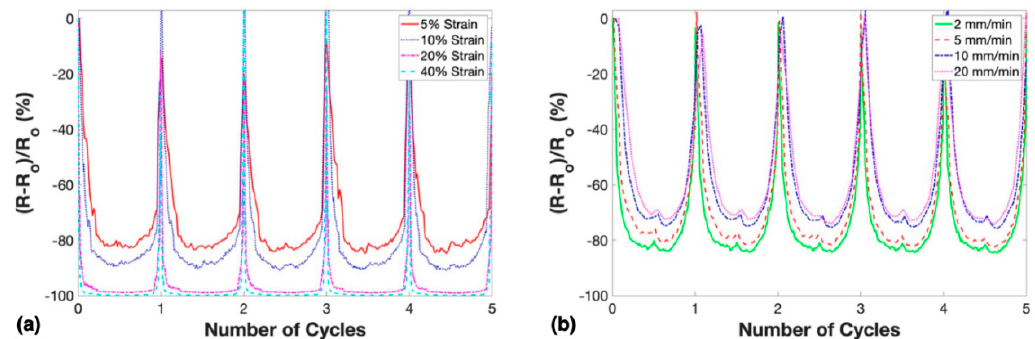
Figure 8. Resistance change as a response to cyclic testing of porous nanocomposites with 2.5 wt. % MWCNTs: ( a ) at various maximum strains and constant crosshead speed and ( b ) at various loading rate and constant maximum strain.